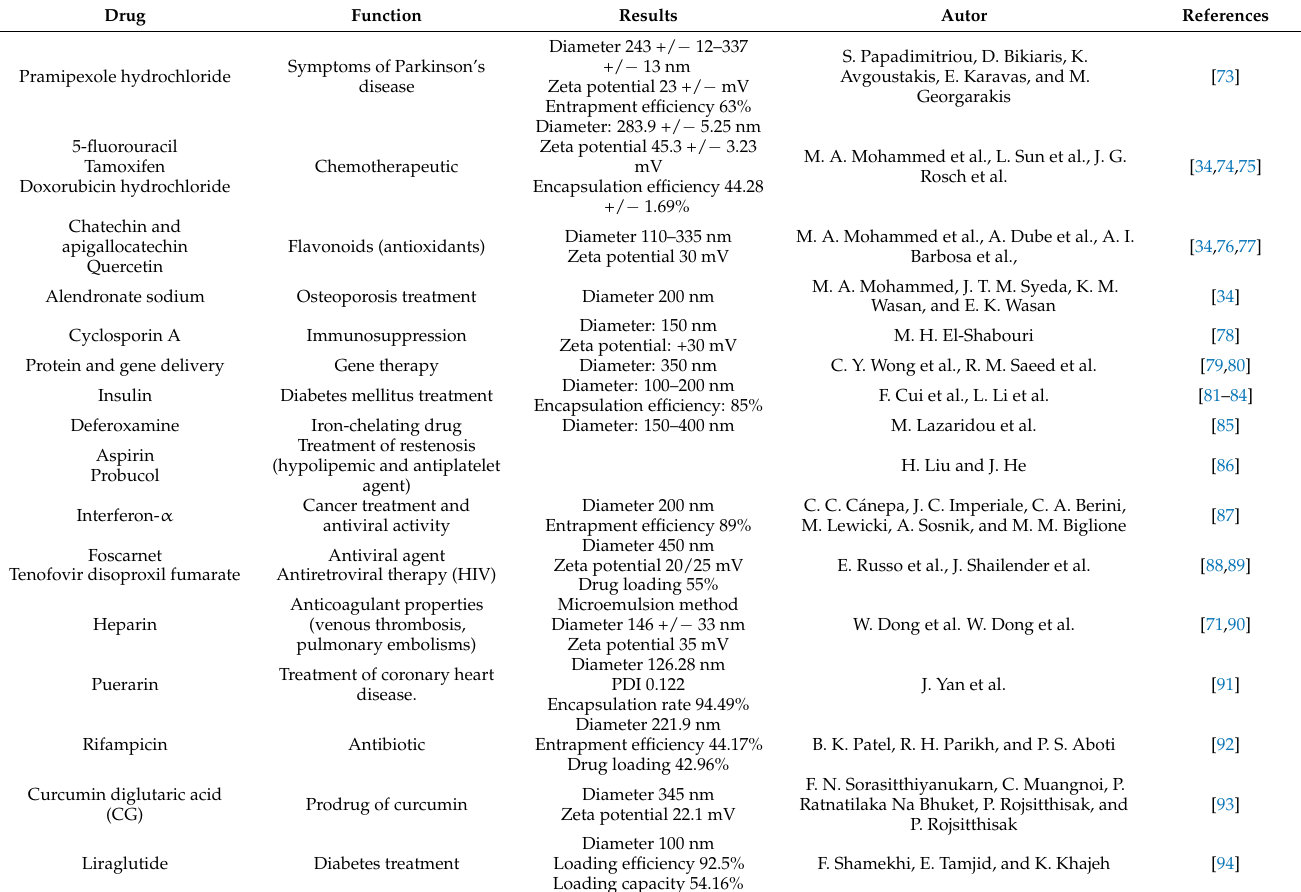
Table 6. Many drugs loaded in chitosan nanoparticles with medical